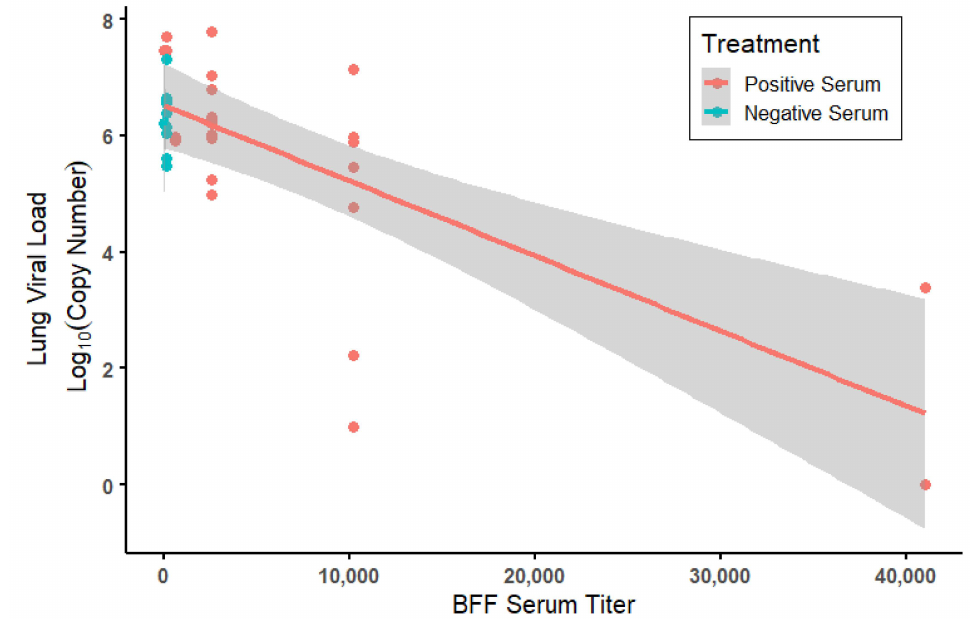
Figure 5. Log 10 viral loads found in the right lungs of SARS-CoV-2 challenged mice in relation to the titer of the black-footed ferret (BFF) serum they received prior to challenge as measured by enzyme-linked immunosorbent assays (ELISA). Each point represents an individual mouse; shading is the standard error for the linear regression represented by the lines. Treatment indicates whether the BFF serum was positive for anti-SARS-CoV-2 antibodies or negative (based on the vaccination status of donor